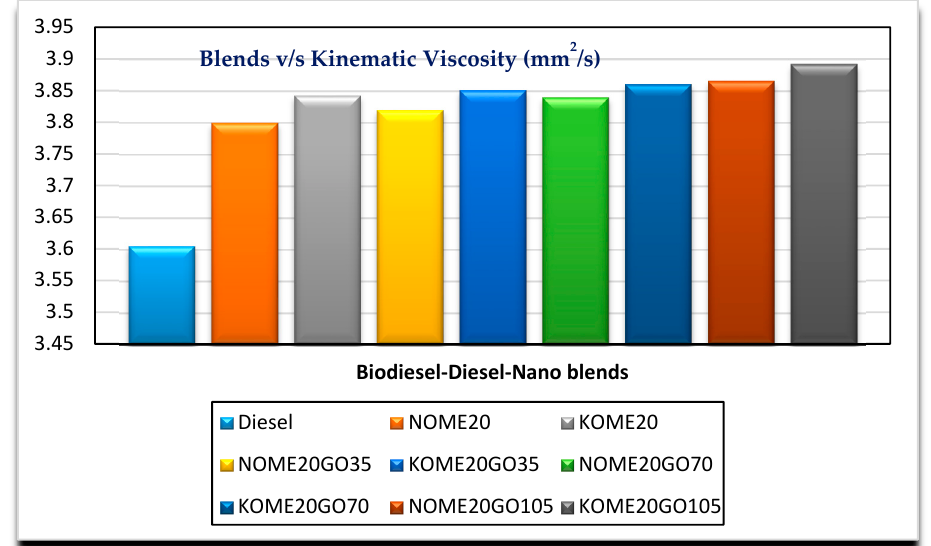
Figure 7. Variation of kinematic viscosity with Biodiesel-Diesel-Nano blends. Table 6. Fuel properties of Neem Biodiesel-Diesel-Nano blends by DT method.